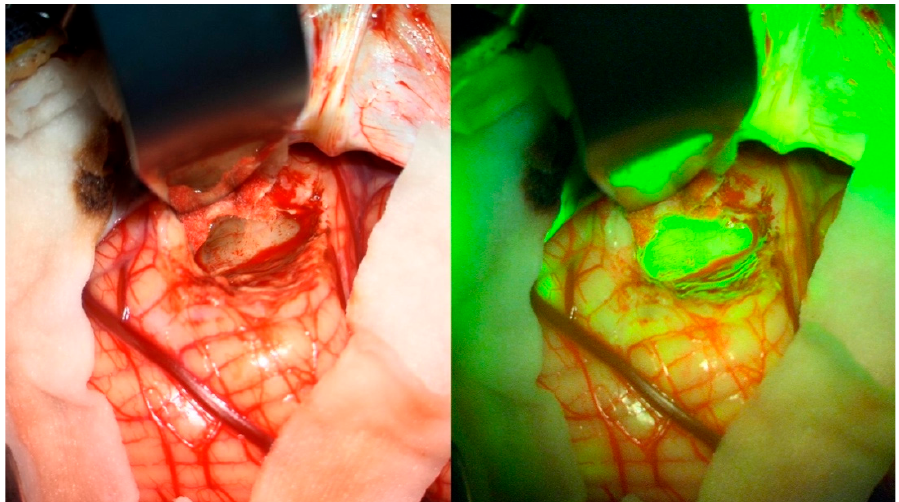
Figure 3. Example of utility in confirming localization. The neuronavigation and the observation using a microscope suggest the surgeon may have reached the tumor ( left ); intraoperative SF fluorescence confirms the localization of altered tissue ( right ).